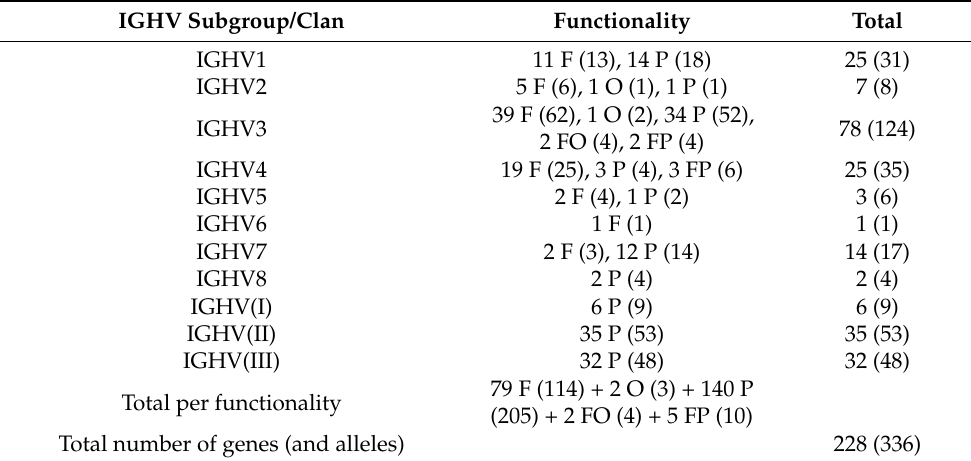
Table 3. For each IGHV subgroup or clan, number of IGHV genes per functionality and, between parentheses, number of alleles. IGHV Subgroup/Clan